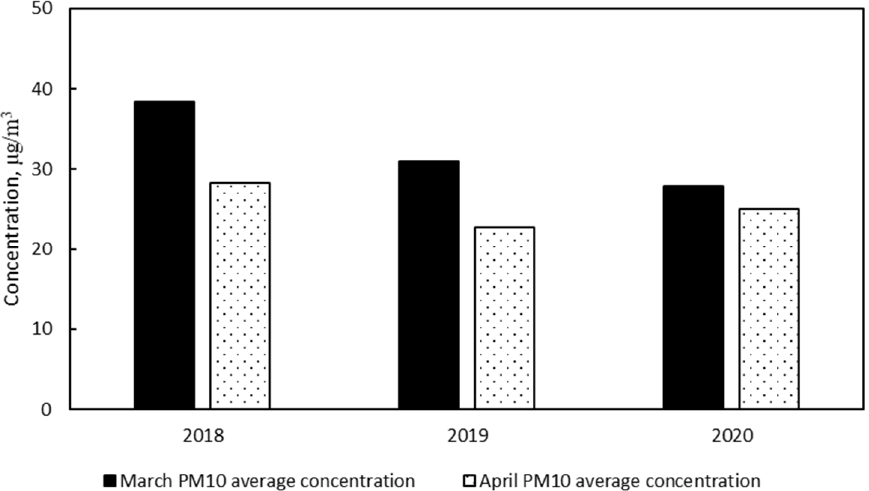
Figure 8. Monthly average concentrations trends of March and April in the years 2018–2020, meas- ured in Milan by ARPA Lombardia.